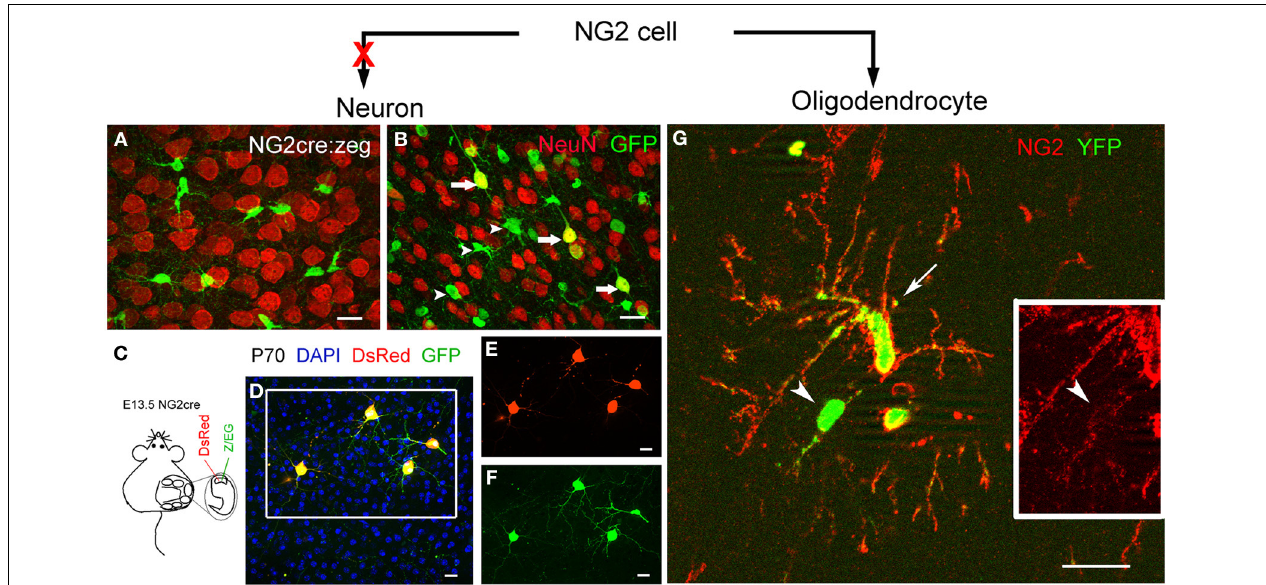
FIGURE 2 | Lineage-dependent and independent reporter expression in Cre-loxP fate mapping. (A,B) Double labeling for GFP and the neuronal marker NeuN in the neocortex of NG2cre:zeg mice at P14 (A) and P70 (B) . NeuN + GFP + cells with mature neuronal morphology (arrows) are seen as well as NeuN- GFP + NG2 cells (arrowheads) in P70 but not in P14 cortex. (C–F) Transfection of zeg reporter plasmid into neuronal precursor cells in NG2cre single transgenic mice. (C) Scheme showing co-transfection of DsRed and zeg plasmid DNA into the lateral ventricles of E13.5 NG2cre single transgenic mice by in utero electroporation and positioning the electrodes to target the dorsal pallium. (D–F) GFP expression in electroporated neurons at P70. All the GFP + cells were neurons that had